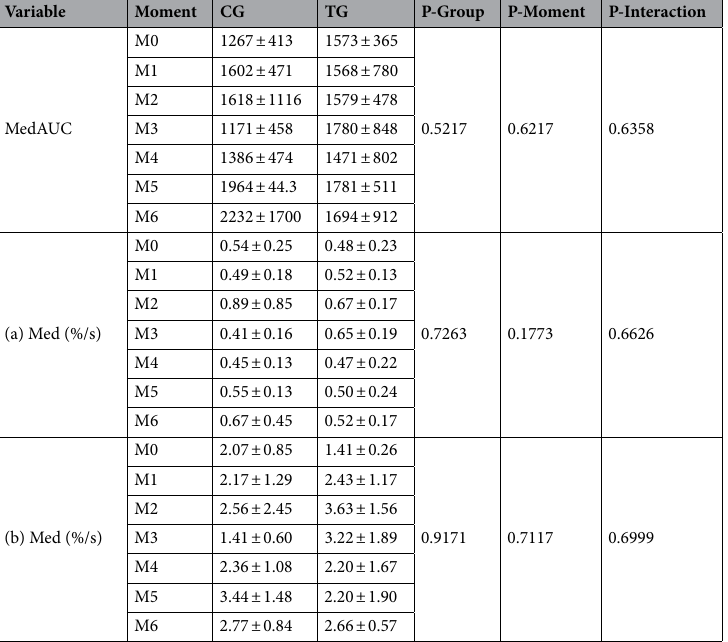
Table 3. Mean ± SD of CEUS evaluation of the left kidney in bitches with mammary carcinoma treated (TG) or not treated (CG) with carprofen 4.4 mg/kg/day for 90 days and evaluated for 6 months. CortPI: cortical peak intensity; CortTmT: cortical mean time of transmission; CortAUC: cortical mean area under the curve; (a) Cort: cortical wash-in slope; (b) Cort; cortical wash-out slope; MedPI: medullary peak intensity; MedTp: medullary time until peak intensity; MedTmT: medullary mean time of transmission; MedAUC: medullary area under the curve; (a) Med: medullary wash-in slope; (b) Med: medullary wash-out